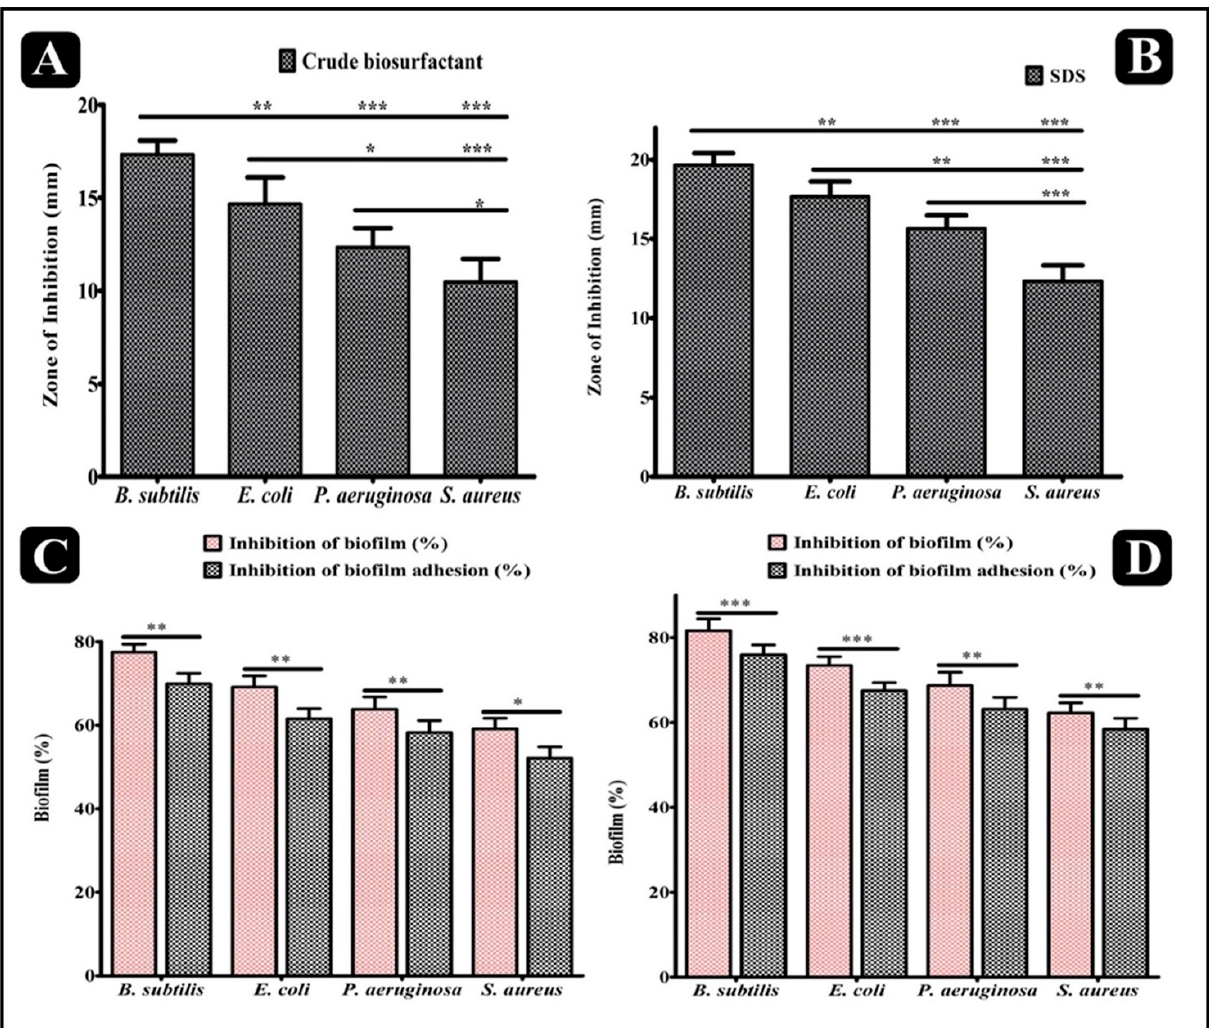
Figure 4. Results of the antibacterial and antibiofilm activity of P. pentosaceus crude biosurfactant and standard SDS. ( A ) Antibacterial activity of P. pentosaceus crude biosurfactant (100 mg/mL) against different bacterial pathogens. ( B ) Antibacterial activity of standard SDS surfactant (1% v / v ) against different bacterial pathogens. ( C ) Effect of P. pentosaceus crude biosurfactant on established biofilms and on adherence ability of different bacterial pathogens at respective MICs. ( D ) Effect of the standard SDS surfactant on the established biofilms and on the adherence ability of different bacterial pathogens at respective MICs. Values are represented as the mean ± SD of three independent experiments. Significance; ns > 0.05, * p < 0.05, ** p < 0.005, *** p < 0.0005. Table 2. Antibacterial activity of the P. pentosaceus crude biosurfactant and standard SDS surfactant.